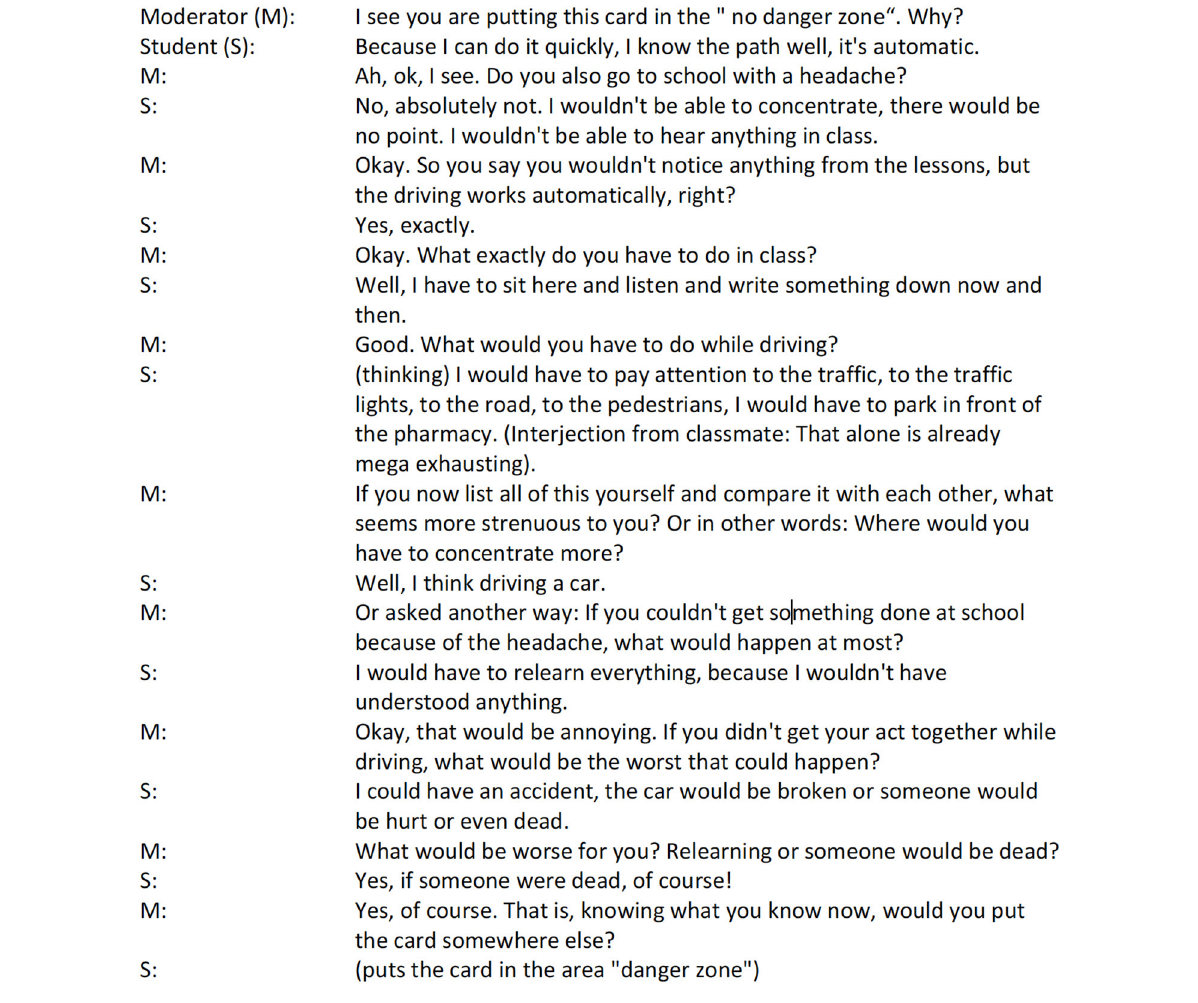
FIGURE6 Documentation of a facilitated conversation role